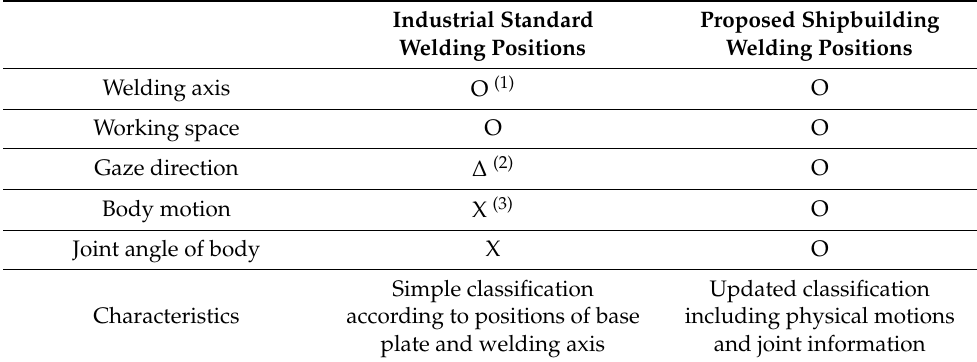
Table 2. Comparison of key features between industrial standard and proposed welding positions.